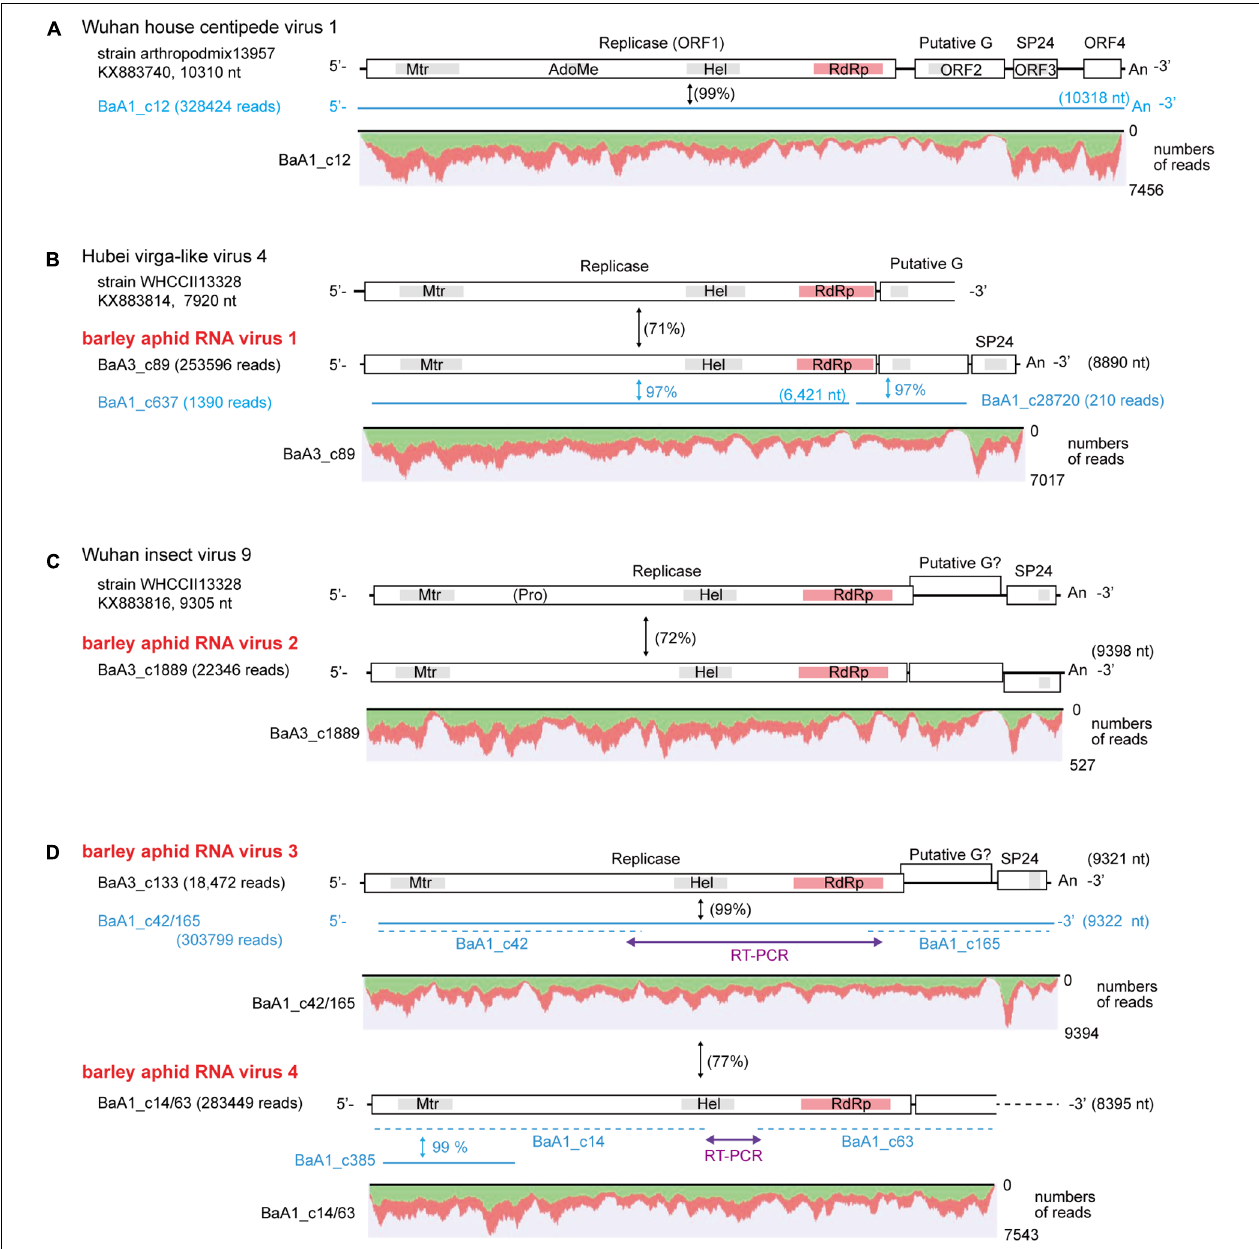
FIGURE 2 | Genome organization of nege/kita-like virus sequences identified from the transcriptomes of barley aphids, Rhopalosiphum padi; R. maidis , and Sitobion avenae . (A) Wuhan house centipede virus 1 genome. (B) Hubei nege-like virus 4 genome (a reference sequence lacking the 3 (cid:48) terminal part) and a related novel aphid virus (named barley aphid RNA virus 1, BARV-1) (C) Wuhan insect virus 9 genome (a reference sequence) and the second novel aphid virus (named barley aphid RNA virus 2, BARV-2). (D) The third and fourth novel aphid viruses (named barley aphid RNA virus 3 and 4, BARV-3 and -4) genome. The open boxes in the genomic RNA represent open reading frames (ORFs). The conserved domains in viral replicase are shown (methyltransferase, Mtr; FtsJ-like RNA ribosomal methyltransferase, AdoMet/FtsJ; RNA helicase, HEL; RNA-dependent RNA polymerase, RdRp). Other putative conserved domains (putative glycoprotein and SP24 protein) are indicated as gray highlights within the ORFs. Virus-like contigs identified from this study are shown as blue bars or blue lines. The sequence gaps between the two contigs for BARV-3 (BaA1_c42 and BaA1_c165) and BARV-4 (BaA1_c14 and BaA1_c63) were determined using RT-PCR and sequencing. The nucleotide sequence identities between a reference virus and a virus-like contig are shown in parentheses with black color. The nucleotide sequence identities between two virus-like contigs are shown in blue color with no parentheses. Read depth coverage throughout the assembled virus-like contigs together with two gap-filling virus-like sequences determined using RT-PCR (BaA3_c42/165 and BaA1_c14/63) is presented below the schematic structures of the viral genomes. The Y-axis shows the mapping-read coverage with the maximum read depth (read number) on each virus-like sequence. Green and red colors indicate positive and negative strand of sequence reads,